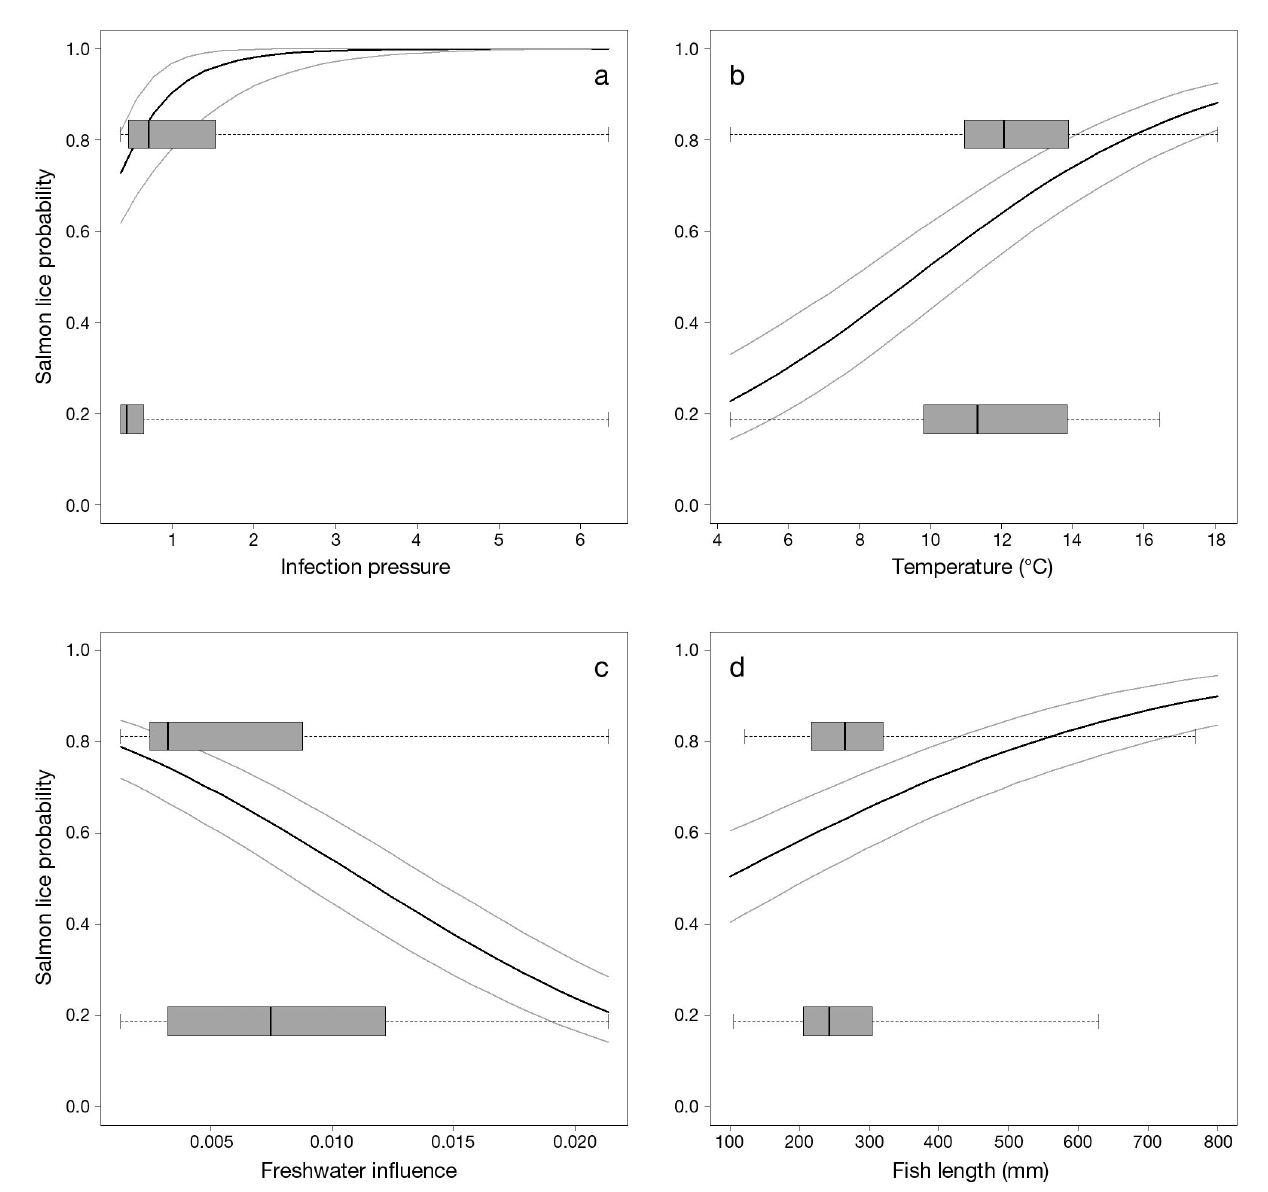
Fig. 3. Predicted probability of a wild sea trout Salmo trutta having salmon lice Lepeophtheirus salmonis as a function of each of the 4 explanatory variables, viz. infestation pressure from farms (estimated from reported counts, see Jansen et al. 2012), temperature, freshwater influence and fish length. Solid black lines represent predicted regression values (parameter values in Table 1), and grey lines show 95% confidence interval. The upper (lower) boxplots in each panel illustrate fish with (with- out) salmon lice. In each boxplot, the black vertical line shows the median, the box marks 25 th −75 th percentiles, and the stippled lines indicate the spread between the minimum and maximum